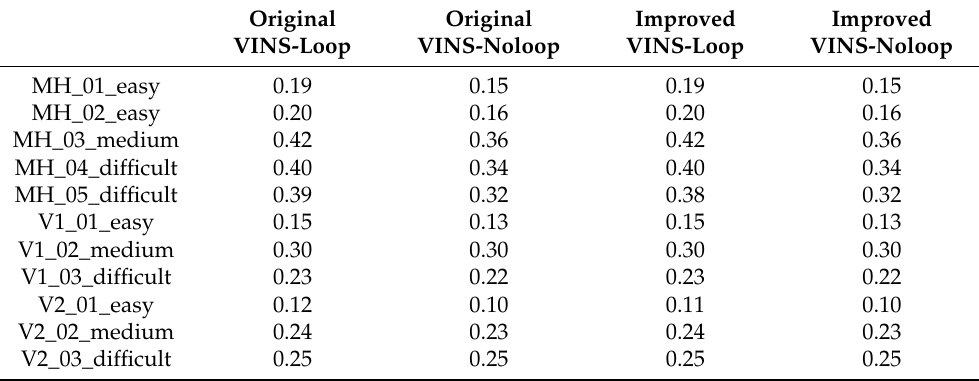
Table 3. The translation error of the original algorithm is compared with that of the improved algorithm. (Unit: